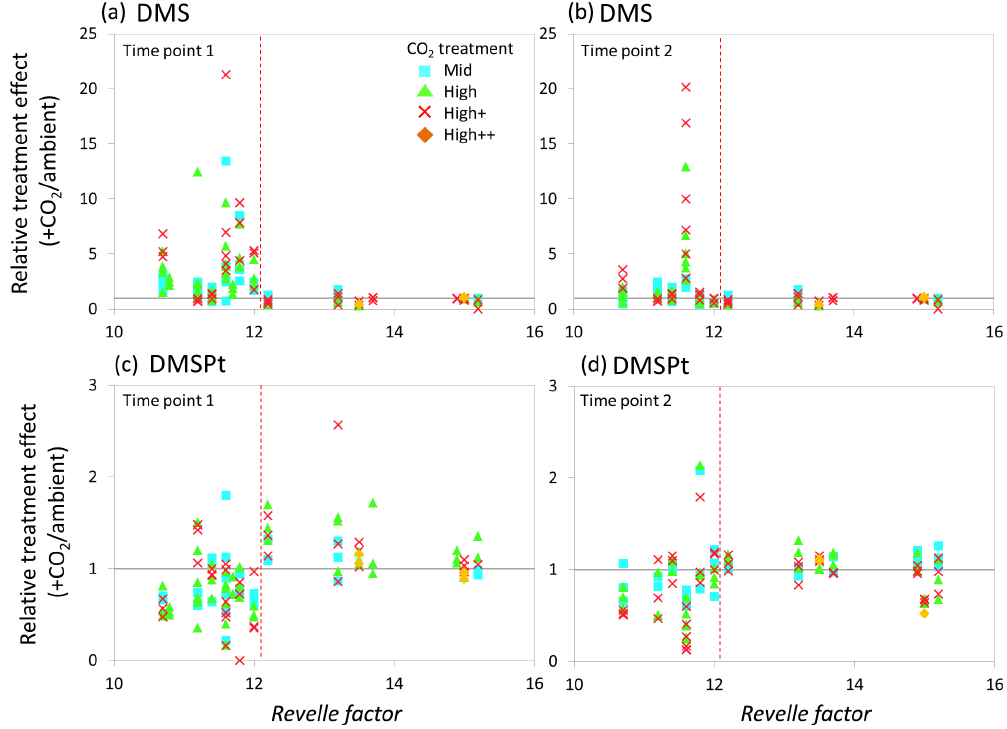
/ [ x ] ambientCO ) 2 2